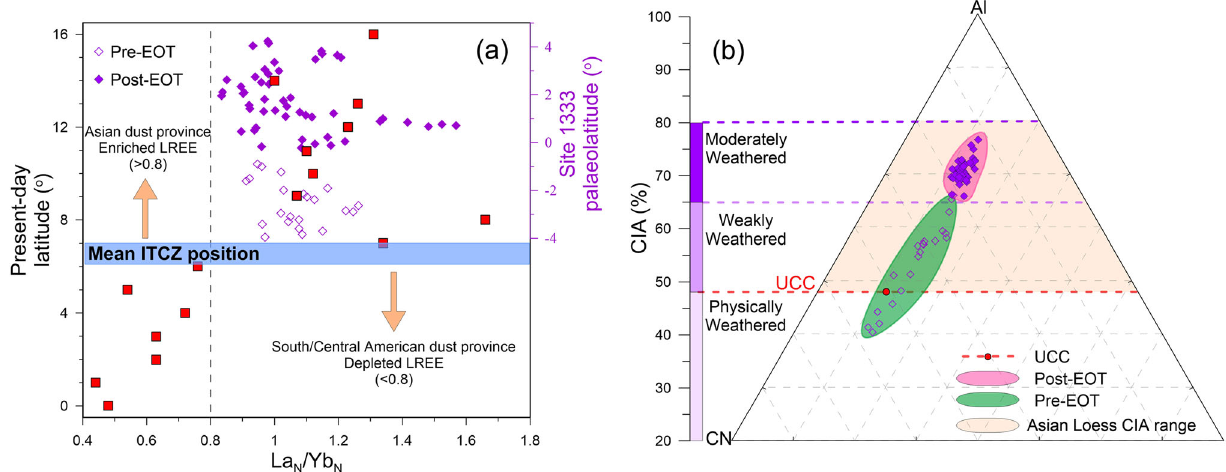
Fig. 4 Dust source regions and CIA pattern. a Mean ITCZ position and EEP dust regimes de fi ned using the La N /Yb N ratio. Red squares: data for 16 sediment cores with respect to latitude from the equator to 16°N along 131.5°W longitude in the central Paci fi c Ocean 34 ; open and solid rhombi: pre- and post-EOT data from ODED at Site U1333. b Al – CN – K (Al 2 O 3 - CaO* + Na 2 O - K 2 O) diagram for Site U1333 and CIA ranges of UCC and Asian Loess refer to Zhang et al. 45 and Taylor and McLennan 60